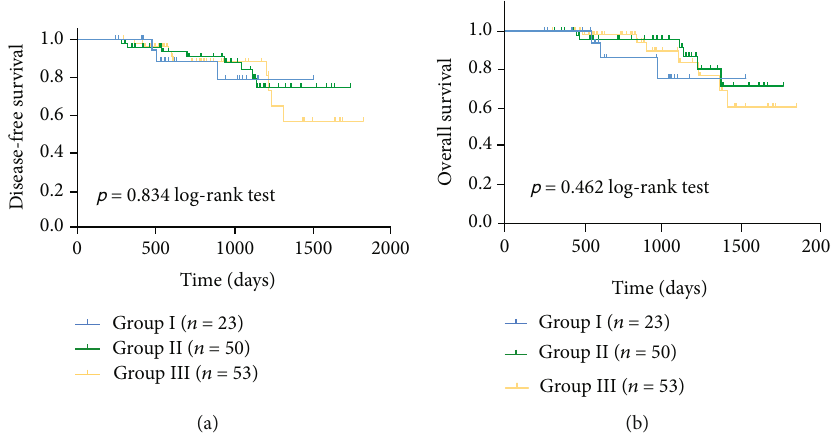
Figure 2: Kaplan-Meier curves of survival between the three groups: (a) disease-free survival and (b) overall